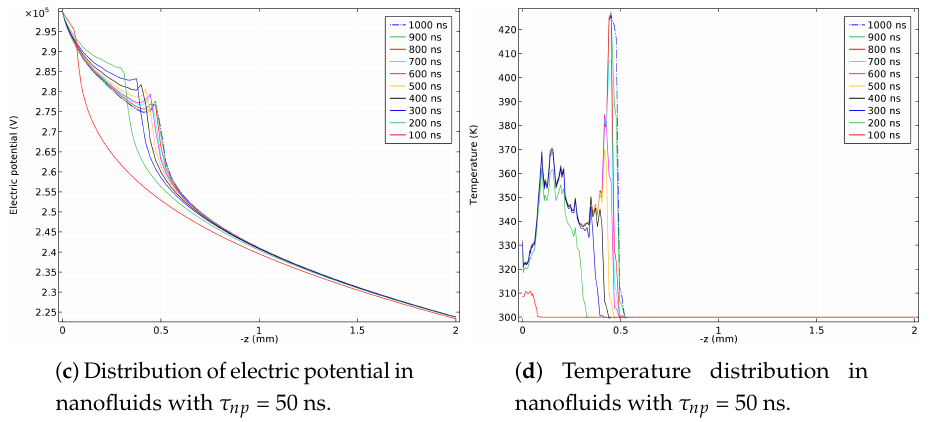
Figure 6. ( a ) Net space charge density, ( b ) distribution of electric field, ( c ) distribution of electric potential, and ( d ) temperature distribution along the z -axis from t = 0 to 1000 ns in intervals of 100 ns from the simulations in nanofluids with τ np = 50